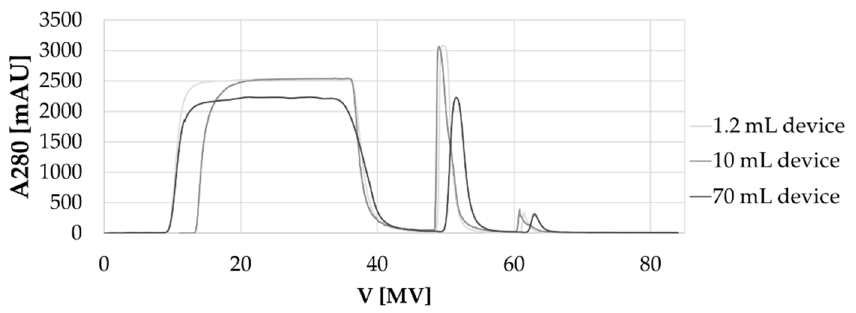
Figure 4. Overlays of UV traces from exemplarily bind and elute cycles of mAb 1 implemented into three different device sizes.